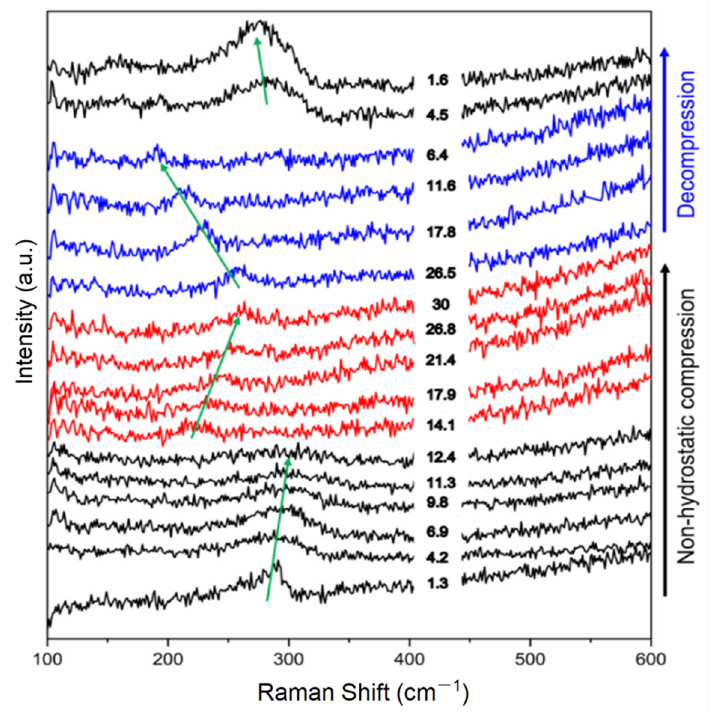
Figure 6. High-pressure Raman spectra of amorphous Ge under non-hydrostatic pressure. Pressures are labeled in each line (unit: GPa). Green arrows indicate the peak shift.